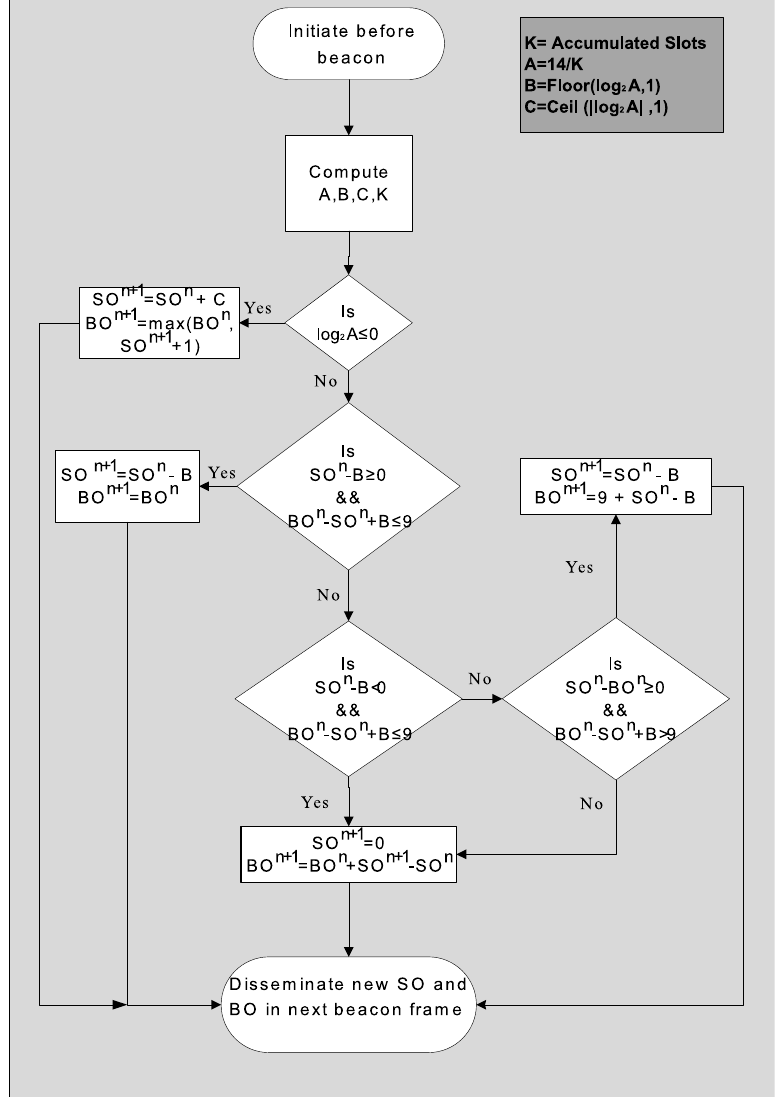
Figure 4. Proposed ESS ADC algorithm.